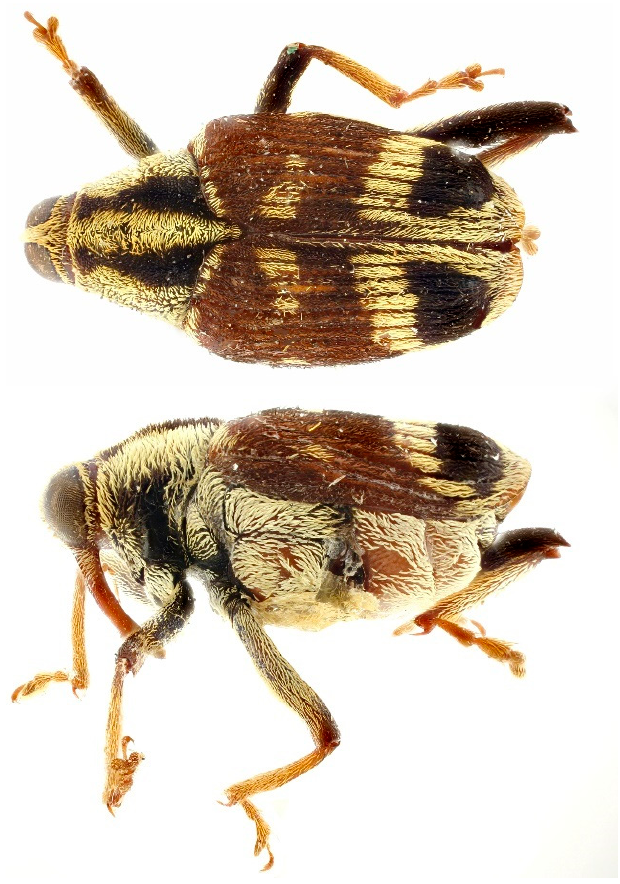
Figure 3. Philenis fuscofemorata Champion, Holotype, dorsal and lateral habitus. Head 0.80 mm wide, 0.40 mm long, convex in dorsal view, eyes separated by 2 rows of small cross section, broadening toward apex, curved, micropunctate below antennal insertions, 1.25 mm long, antennae inserted at basal 1/5.